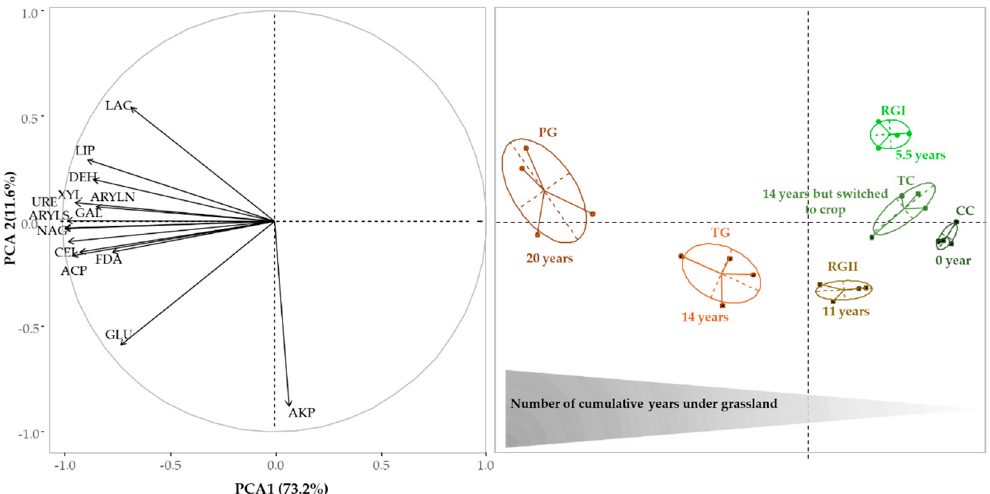
Figure 2. Principal component analysis and correlation circle of plots enzyme activities.